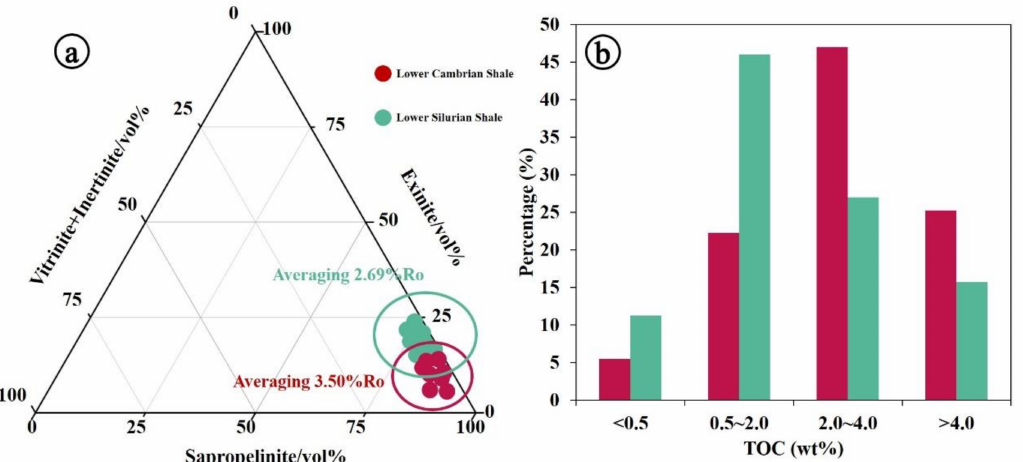
Figure 3. ( a ) Ternary plot of maceral compositions and thermal degrees. Sapropelite shared 75 vol% of the total maceral volume in both lower Cambrian shale and in lower Silurian shale, ( b ) histogram of TOC distribution in both lower Cambrian shale and in lower Silurian